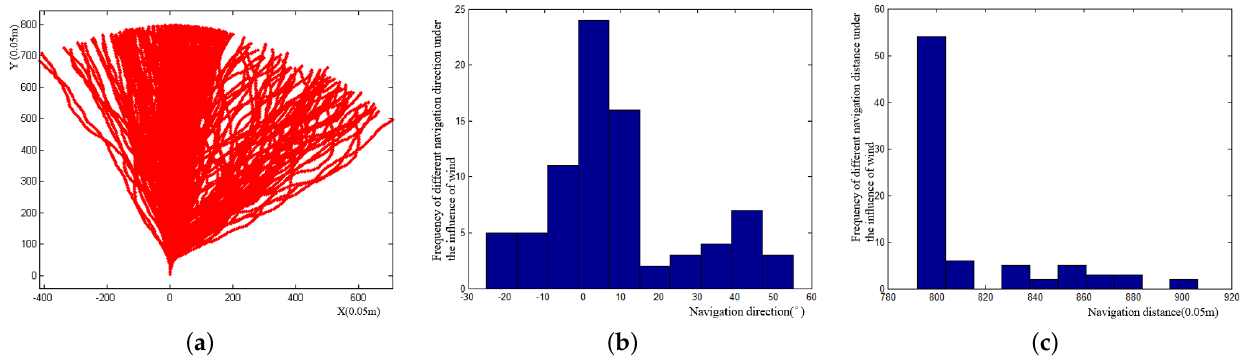
Figure 7. Wind impacts from 0 to 8 m/s. ( a ) Trajectories under wind disturbances from 0 to 8 m/s. ( b ) Heading statistics of wind impacts from 0 to 8 m/s. ( c ) Distance statistics of wind impacts from 0 to 8 m/s.